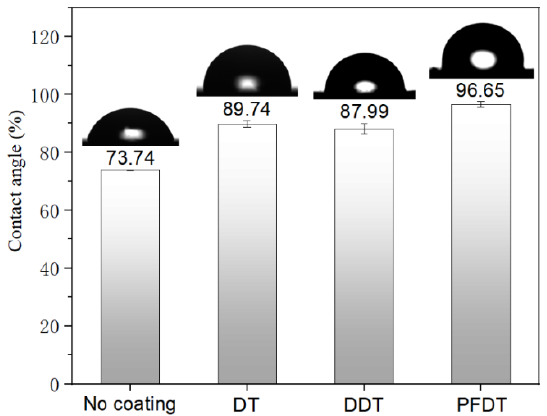
Figure 7. Contact angles of different alkyl mercaptan SAMs deposited on the insert surface